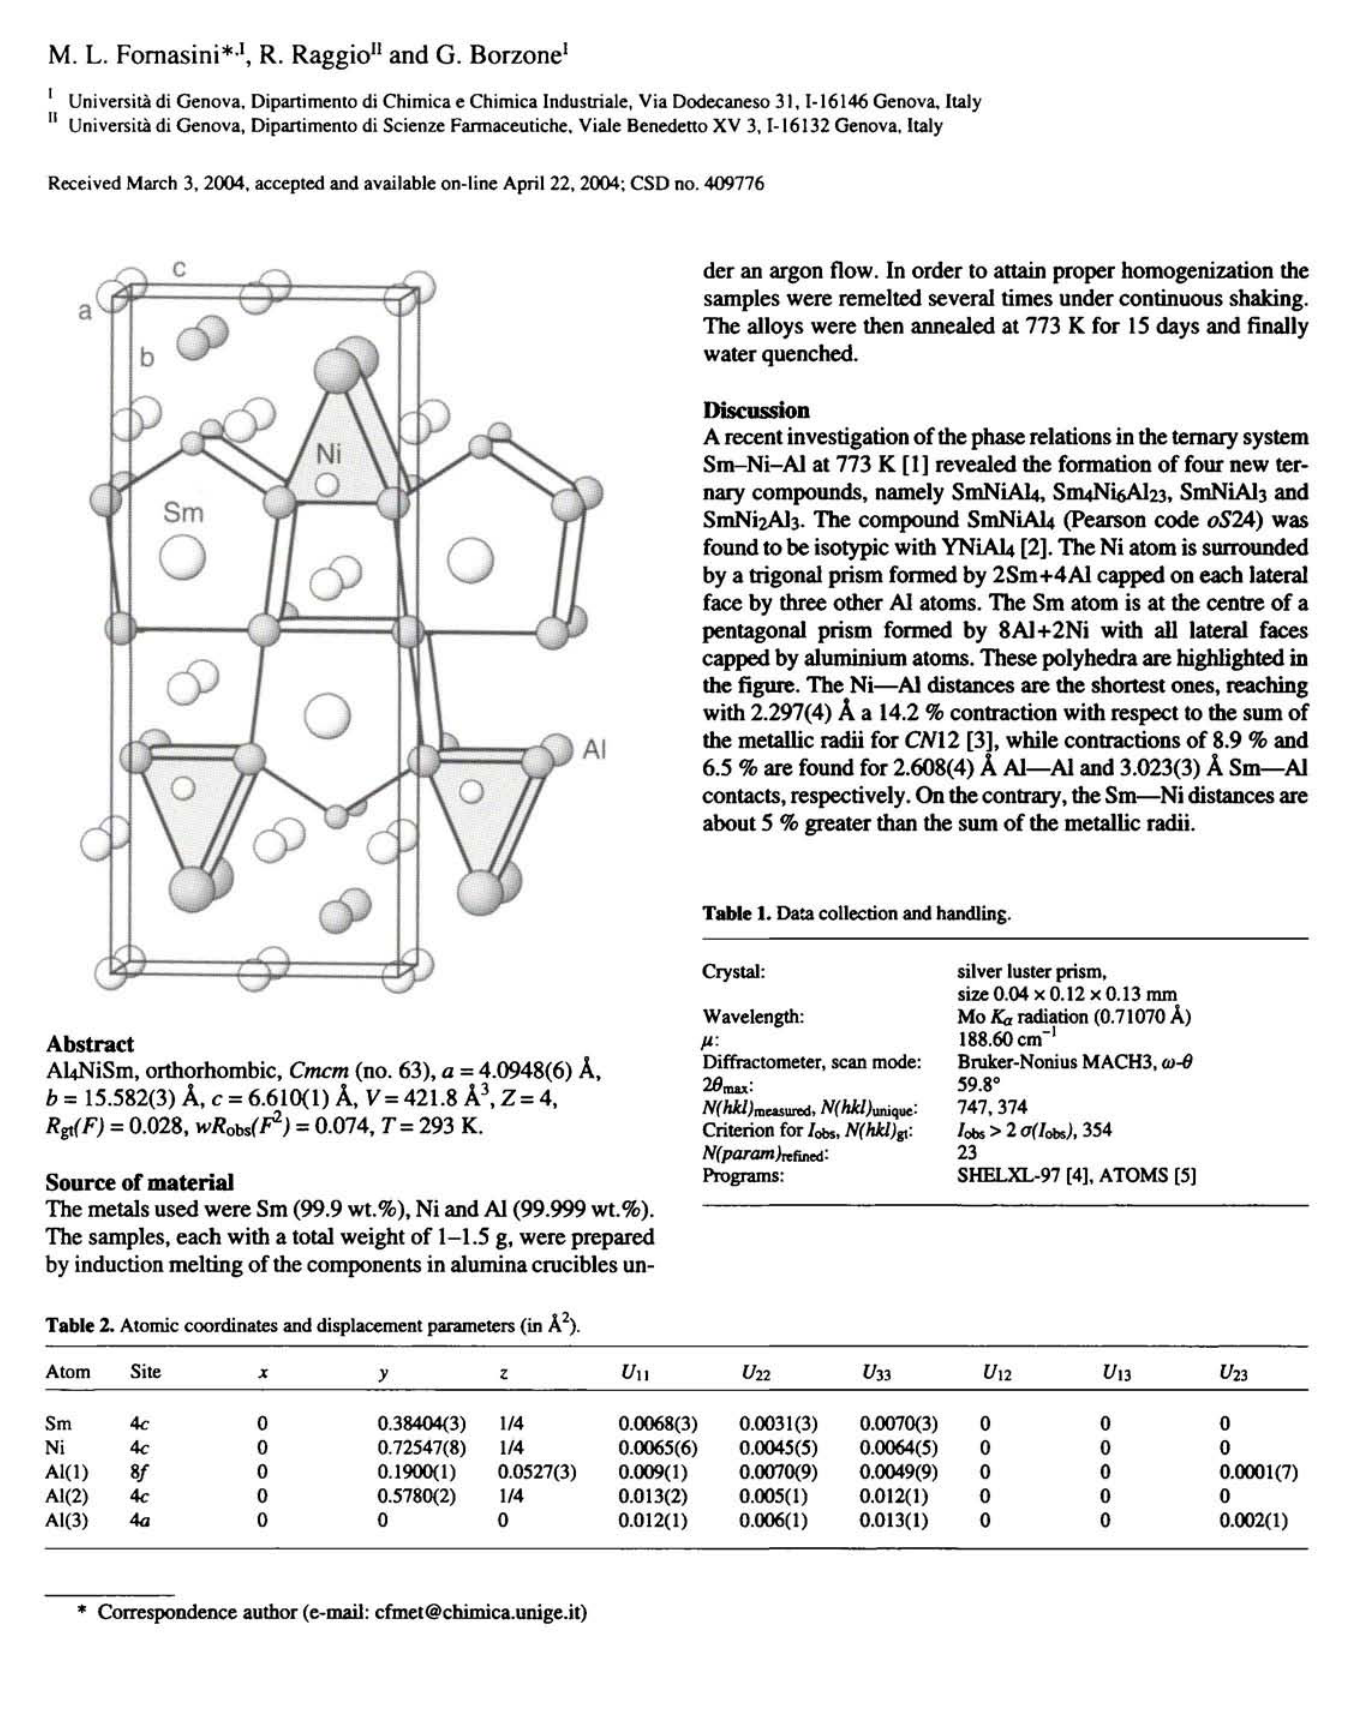
Table 2. Atomic coordinates and displacement parameters (in A 2